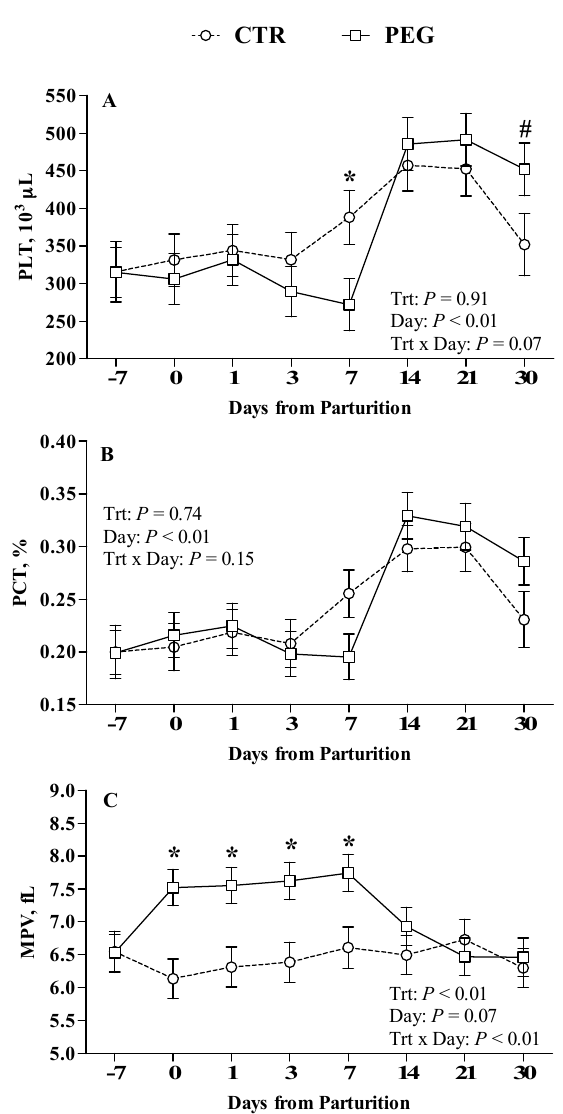
Figure 6. E ff ect of Pegbovigrastim on PTLs and their parameters. Least-squares means ± standard error of ( A ) platelet count (PLT, × 10 3 / µ L), ( B ) platelet crit (PCT, %), and ( C ) mean platelet volume (MPV, fL) during the transition period of Simmental cows treated either with 2 subcutaneous injections of pegbovigrastim (PEG) or saline solution (CTR) at –7 days relative to calving and within 6 h after calving. Asterisks (*) indicate di ff erences at p < 0.05, whereas hashtags (#) indicate tendency at 0.10 ≥ p > 0.05.